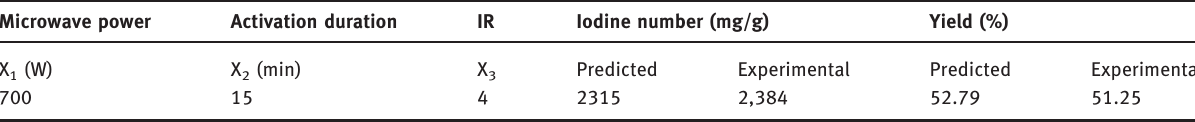
Table 6: Validation of process optimization. Microwave